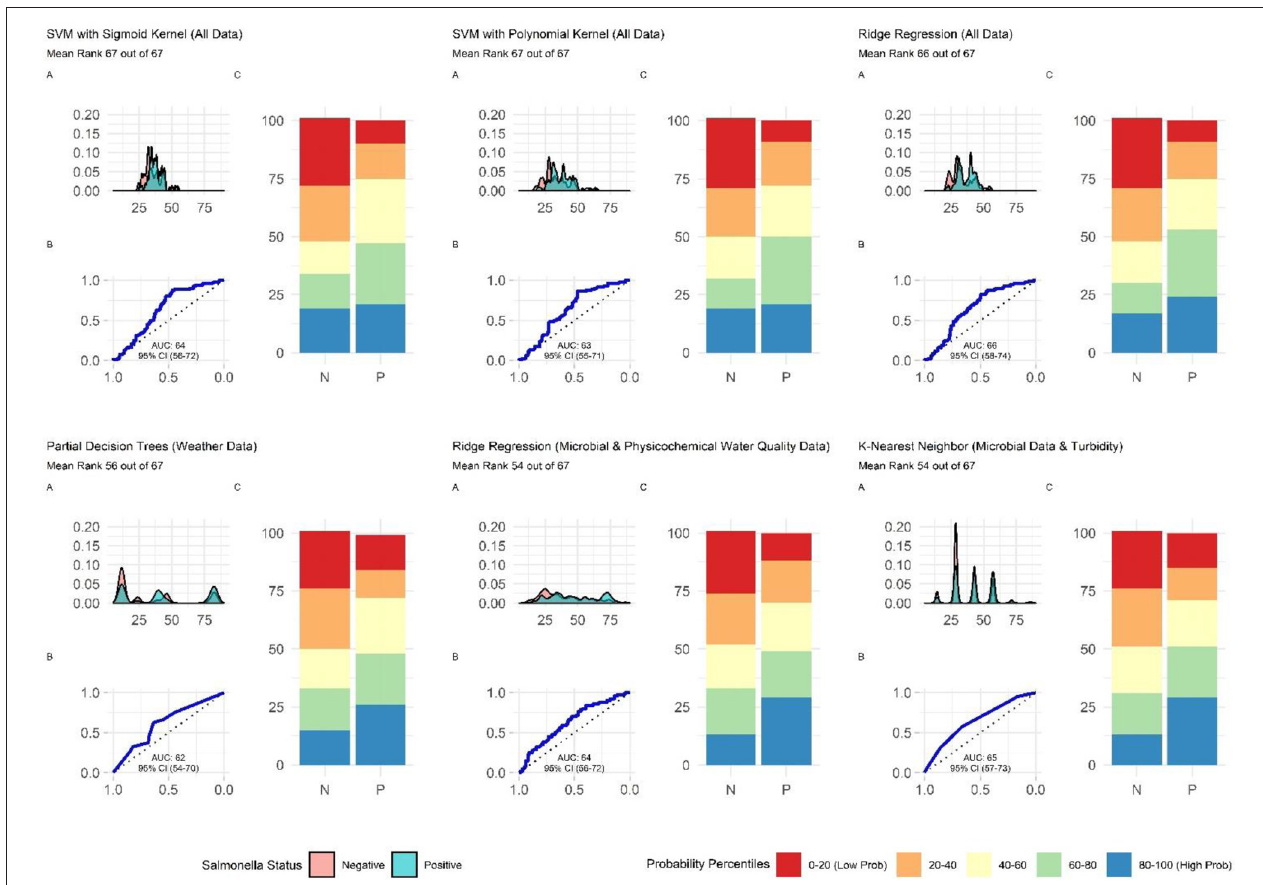
FIGURE 7 | Plots showing the performance of the top-ranked full and nested Salmonella models. (A) Shows how well the model can distinguish samples that tested positive and negative for Salmonella . The x-axis of (A) is the probability of Salmonella detection generated by the model, and the y-axis is density. (B) Is the receiver-operating curve (ROC) for the model; the x-axis is 1-Specificity and the y-axis is Sensitivity. (C) Shows how well the model is at accurately classifying positive and negative samples. The split quantiles plot is generated by sorting the test data from lowest to highest probability of Salmonella detection based on the given model. The test data is then divided into quantiles (based on the percentile the probability falls into). The proportion of samples in each quantile that were actually Salmonella -positive or negative were then plotted. A good model would identify all low probability percentile samples (red) as negative (N) and all high probability percentile samples (blue) as positive